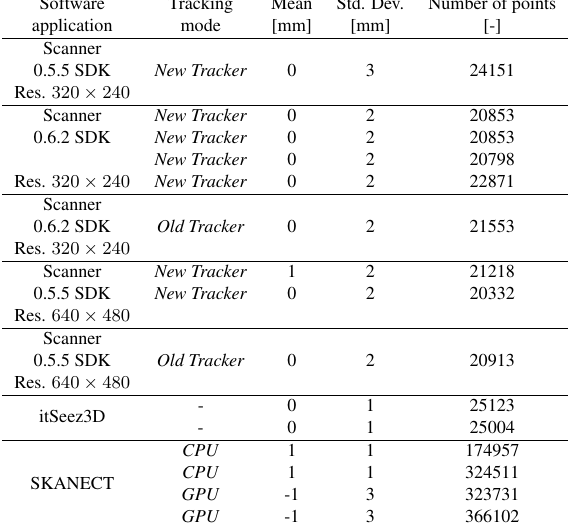
Table 1: Distance statistics of the